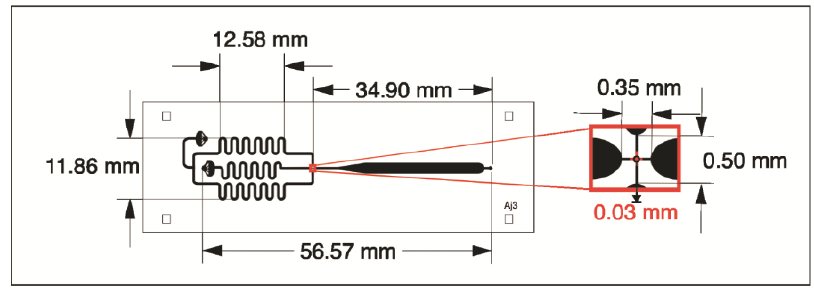
Figure 2. Droplet-forming microdevice design.